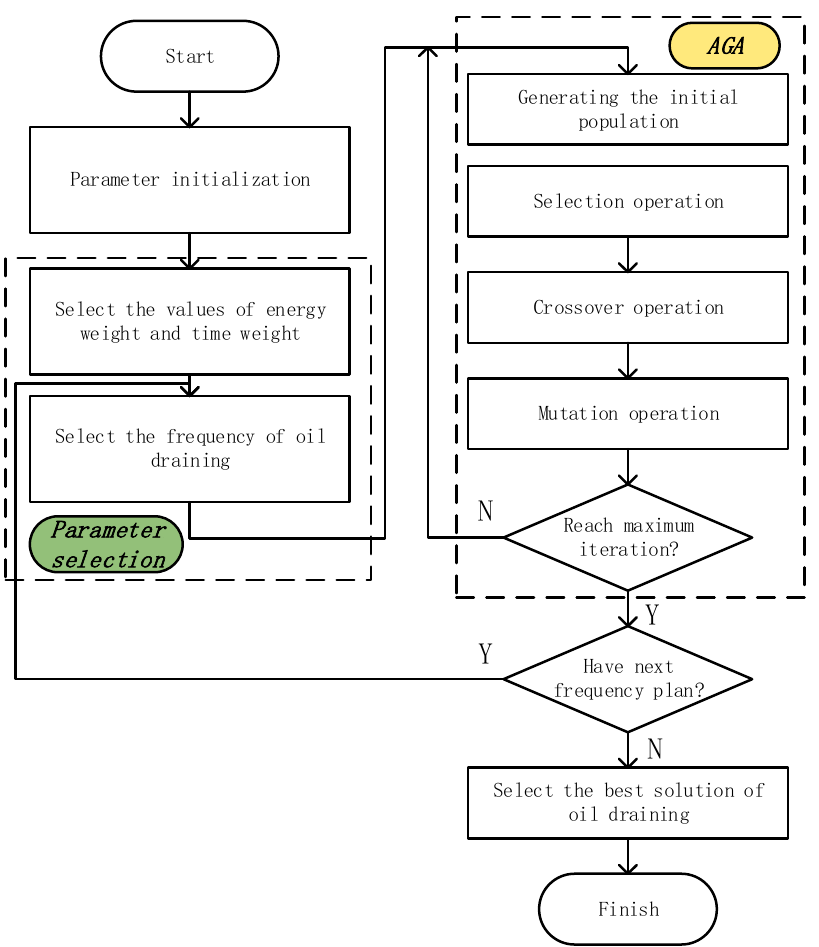
Figure 5. Implementation process of the buoyancy regulation strategy.